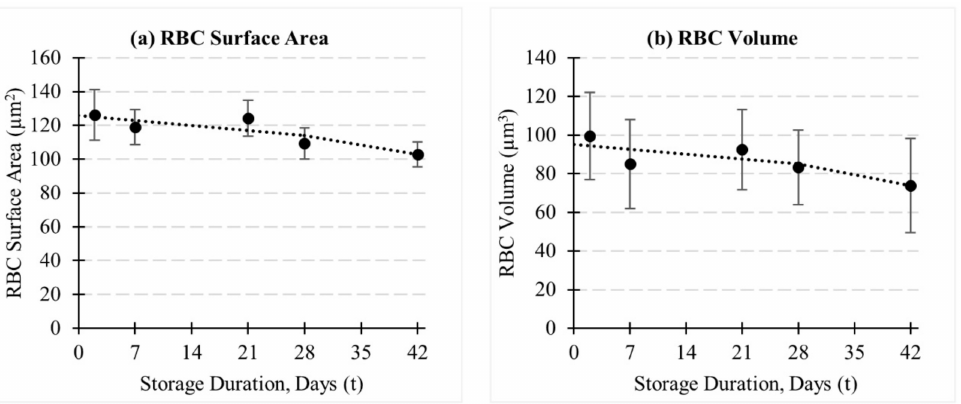
Figure 3. Evolution of ( a ) cell surface area ( A 0 ( t ) ), and ( b ) cell volume ( V 0 ( t ) ) of in-vitro stored RBCs.